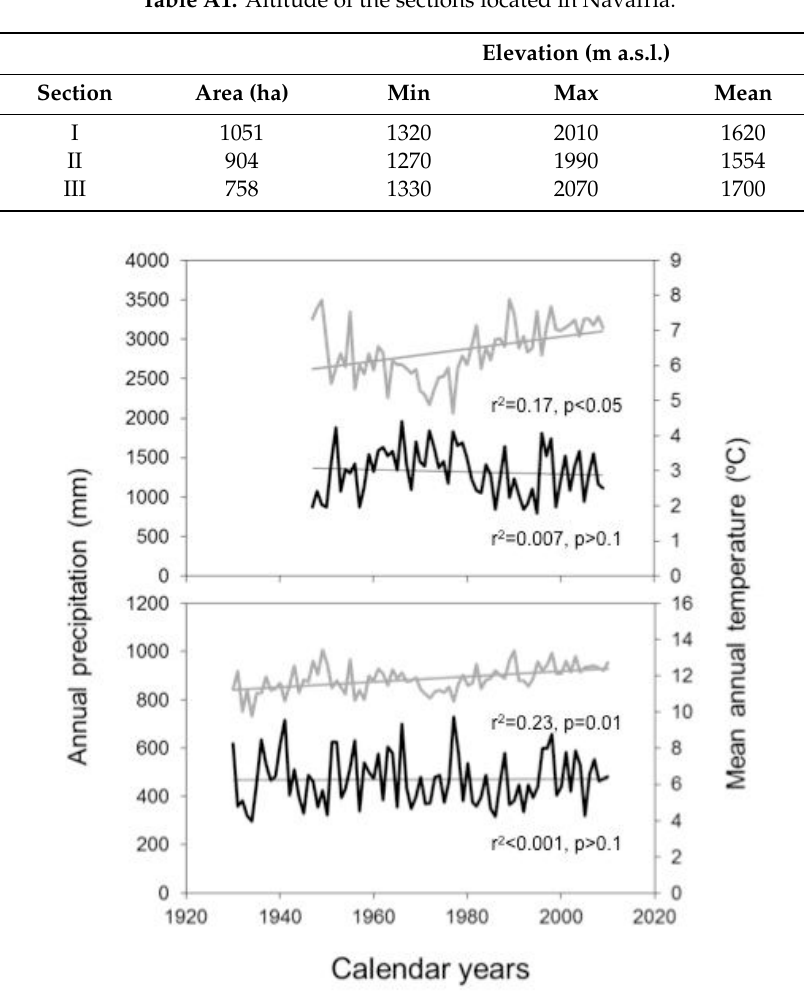
Figure A1. Annual rainfall (black lines) and mean temperature (grey line) through time in the Puerto de Navacerrada (upper panel) and Segovia city (bottom panel) located at 1894 m a.s.l. and 1002 m a.s.l. respectively (Data from AEMET).